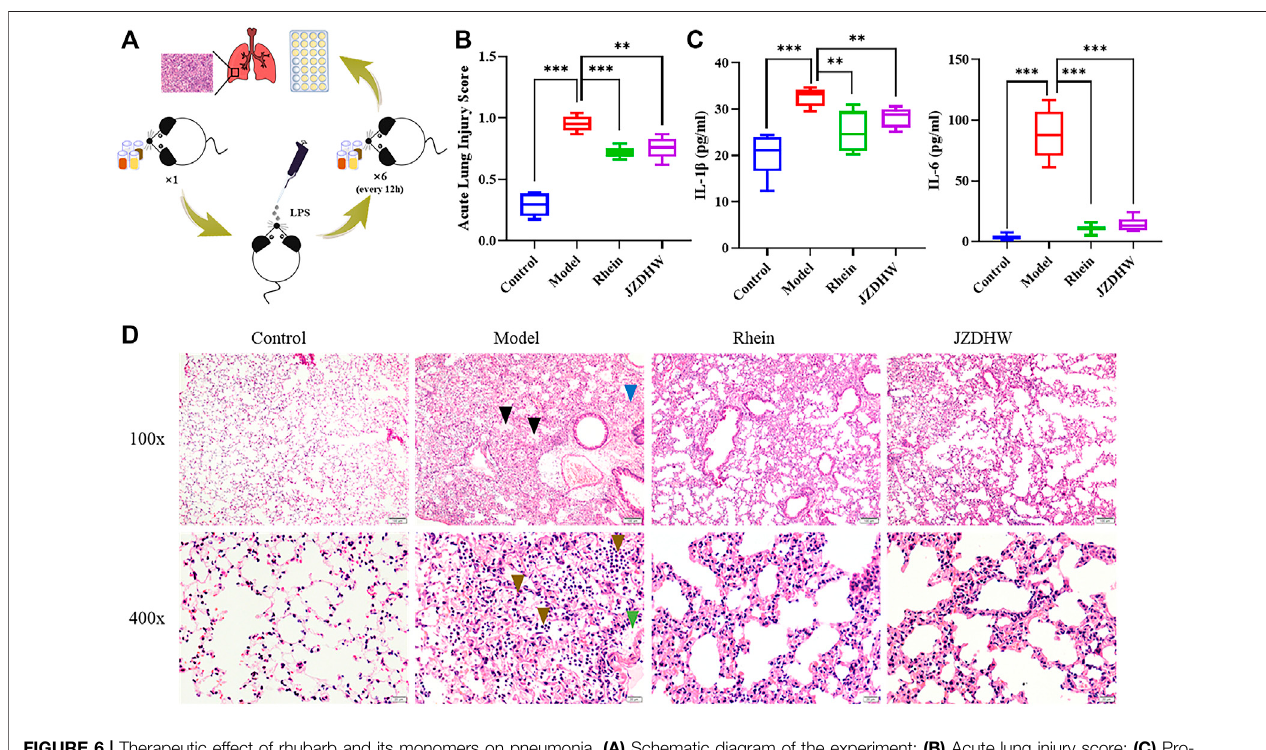
FIGURE 6 | Therapeutic effect of rhubarb and its monomers on pneumonia. (A) Schematic diagram of the experiment; (B) Acute lung injury score; (C) Pro- in fl ammatory factor ELISA test; (D) Tissue section (100 × magni fi cation and ×400). indicates oedema, indicates bleeding, indicates in fl ammatory cells, and indicates fi brin oozing out of the alveoli. The results are given as mean ± standard error of the mean ( n =